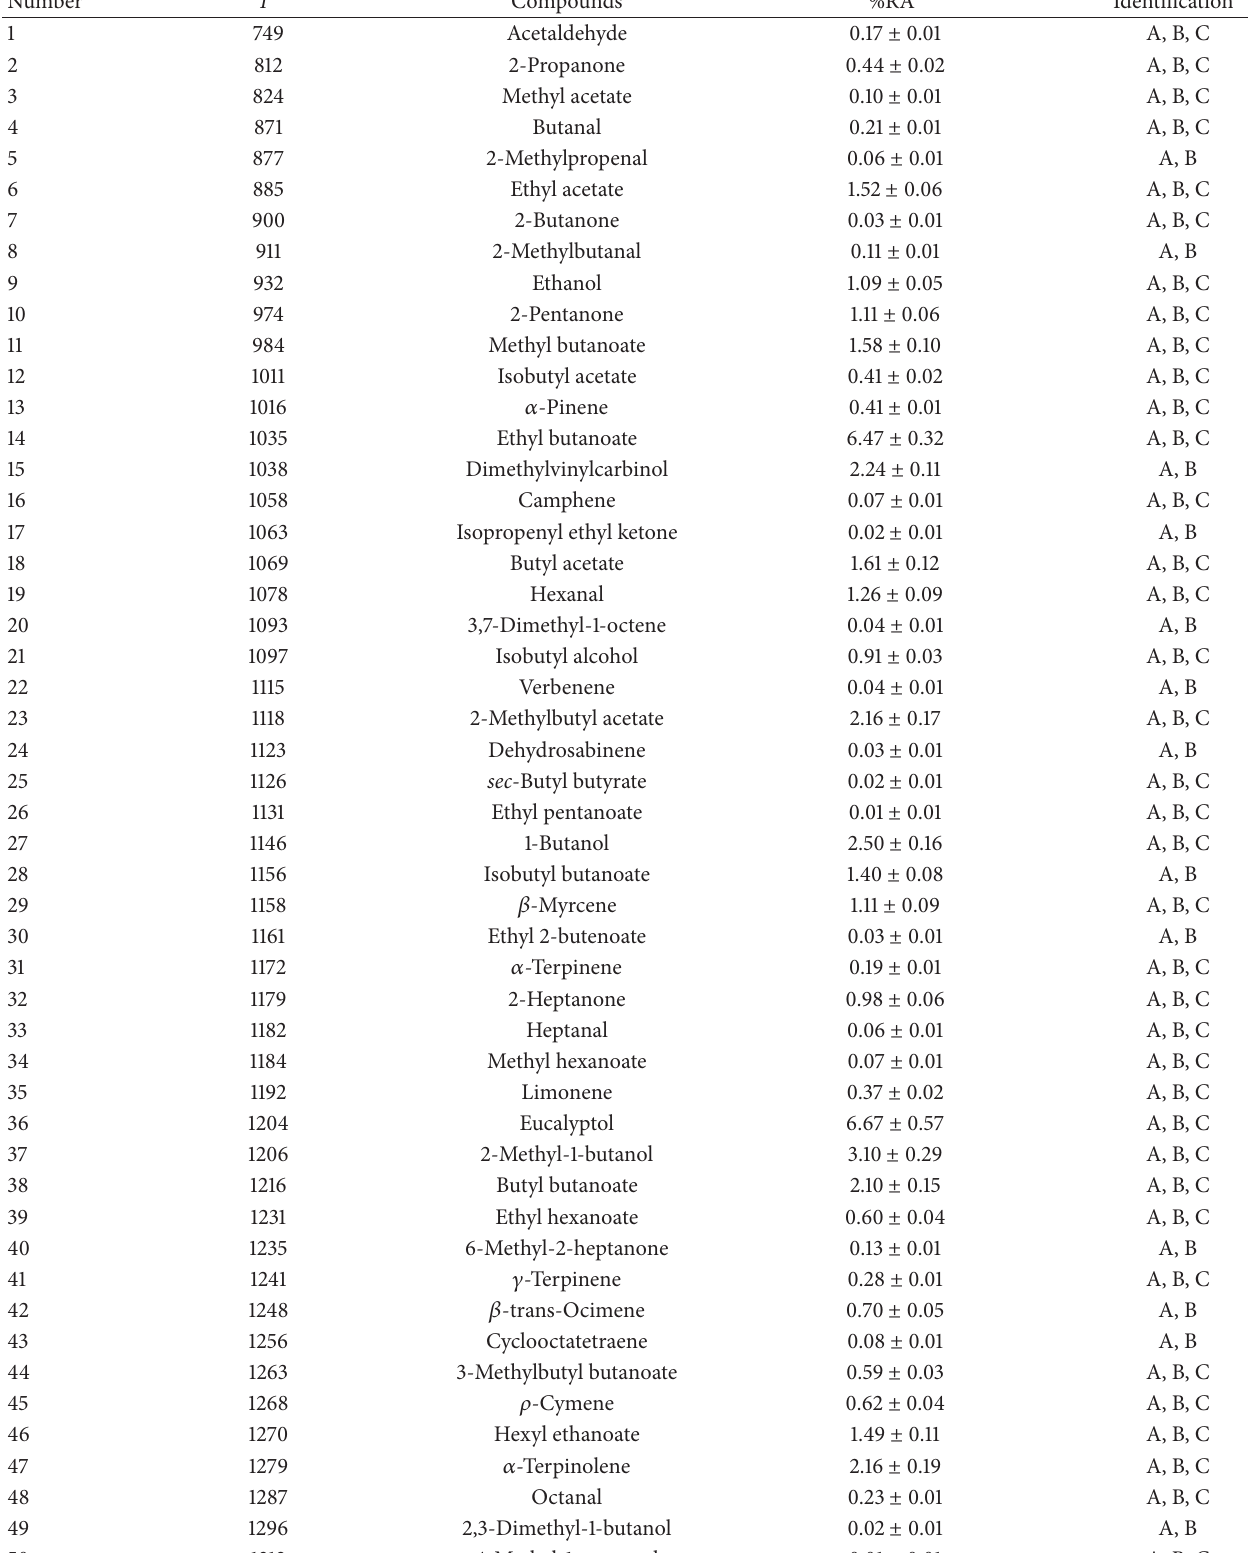
Table 1: Volatile compounds of Cape gooseberry fruit obtained by